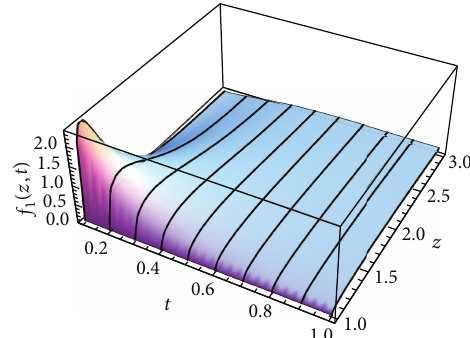
Figure 5: Plot of 𝑓 1 (𝑧,𝑡) given by (67) in Example 14 at different values of 𝑡 = {0.1, 0.2, 0.3, . .. ,1} (corresponding to the solid lines) in the case that 𝐵 ∼ 𝜒 2 (3) , 𝑡 0 = 0 , and 𝑧 0 = 1